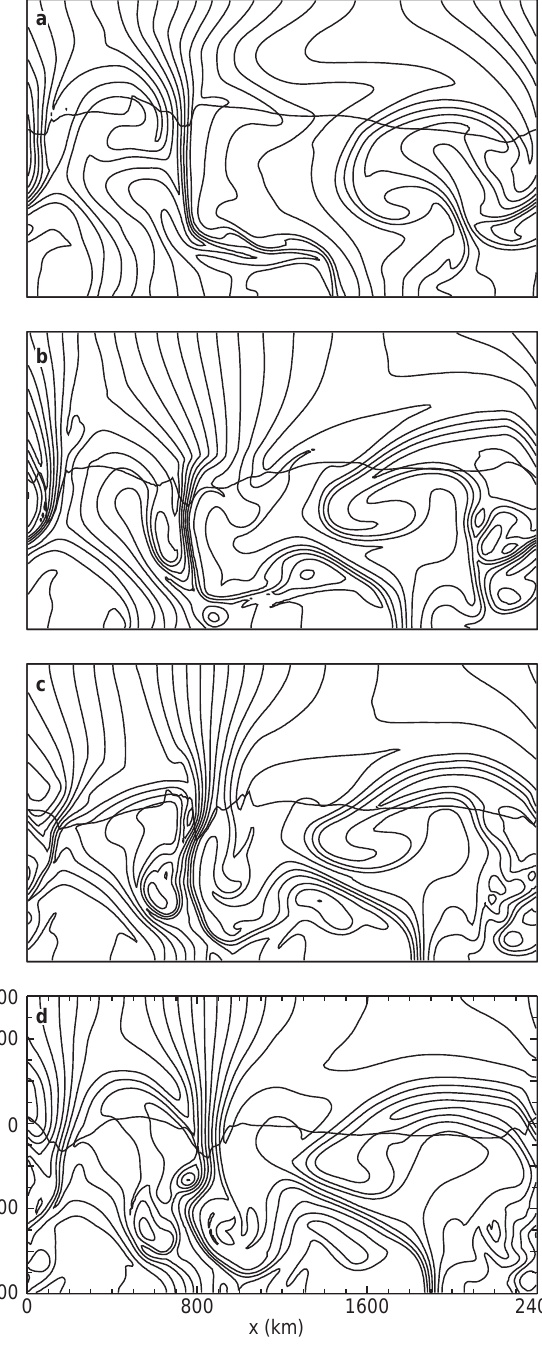
a distance of 2400 km. The y -coordinate runs 1400 km in the vertical (height) direction, ranging from 800 km below the surface (optical depth unity at 500 nm for a mean solar atmosphere model) to 600 km above it. Top and bottom boundaries are open for the flow; the side boundaries are periodic. The horizontally running dotted curve indicates optical depth unity for the continuum radiation at 500